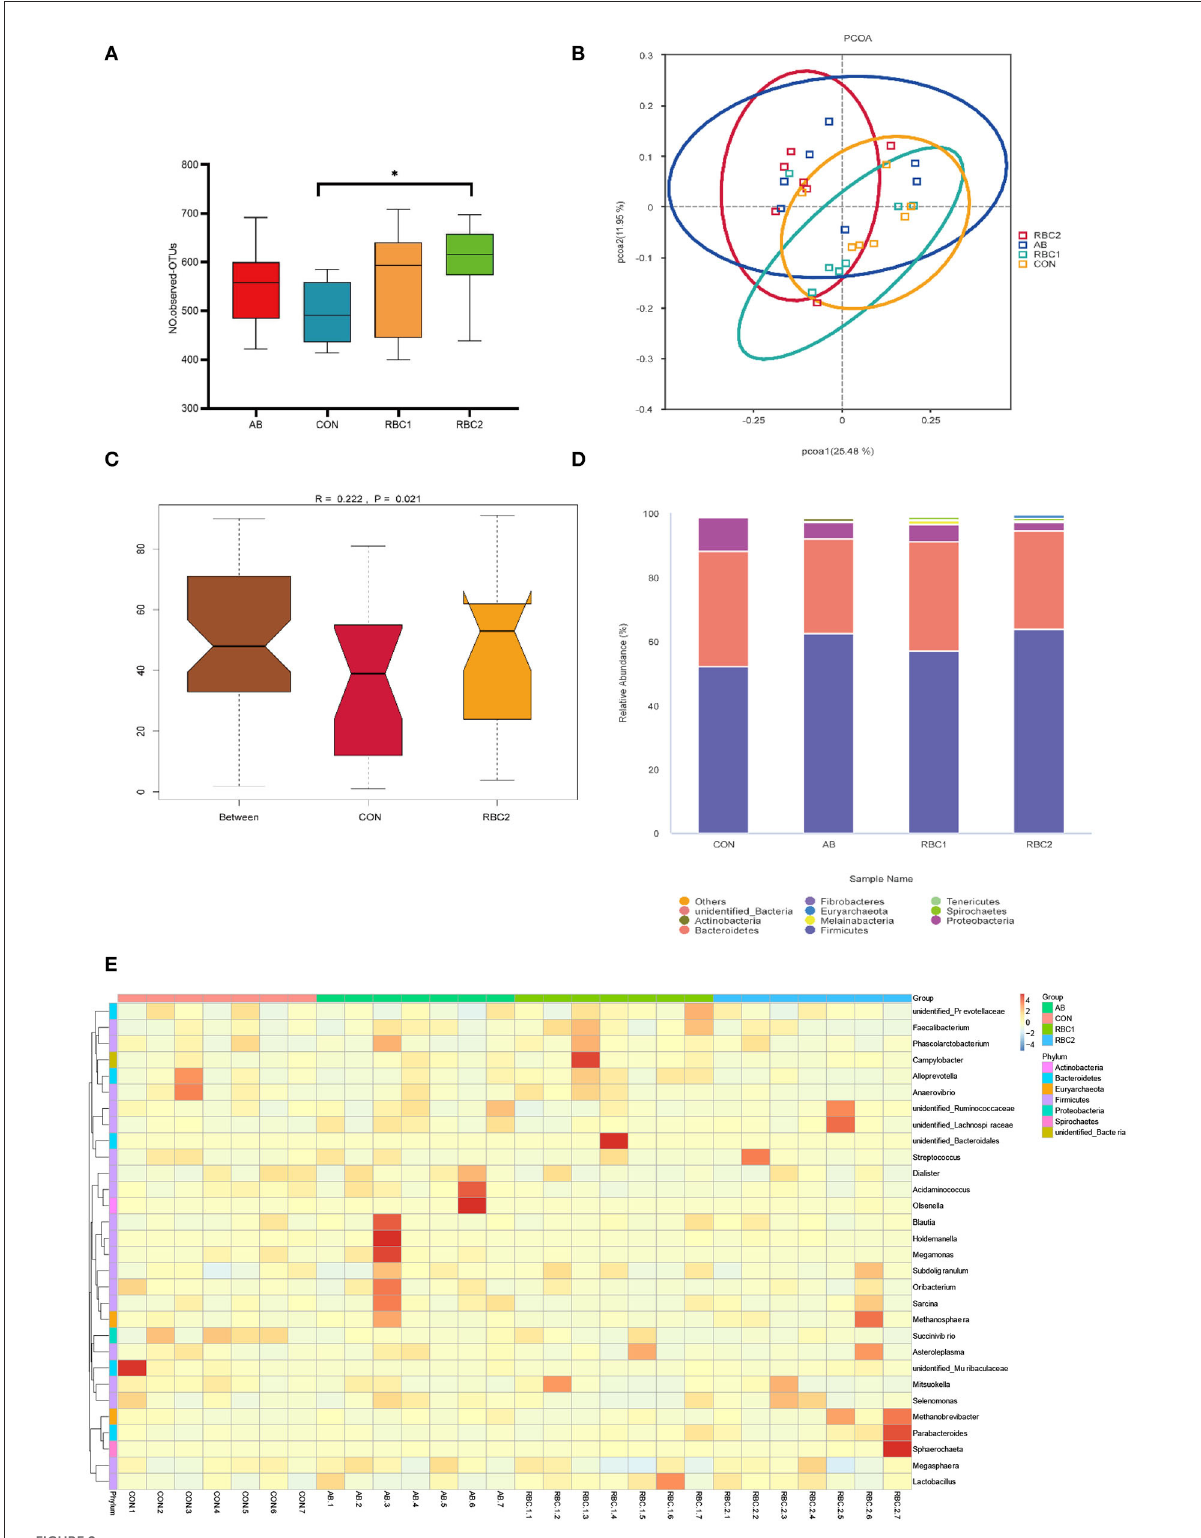
FIGURE2 Effect of dietary AB and RBC on the relative abundance of microbiota at the phylum and genus level, and PCoA and Adonism of weaned piglets. (A) Operational taxonomic units (OTUs) number in each treatment group. (B) Principal coordinates analysis (PCoA). (C) Analysis of similarities (ANOSIM) between CON and RBC2 group. (D) Microbiota abundance at the phyla level. (E) Microbiota abundance at the genus level. n = 7 for each treatment. CON, basal diet; AB, basal diet + 25 mg/kg bacitracin zinc + 5 mg/kg colistin sulfate; RBC1, 5 g/kg reduction in soybean meal of basal diet + 5 g/kg RBC; RBC2, 10 g/kg reduction in soybean meal of basal diet + 10 g/kg RBC. *Means P <